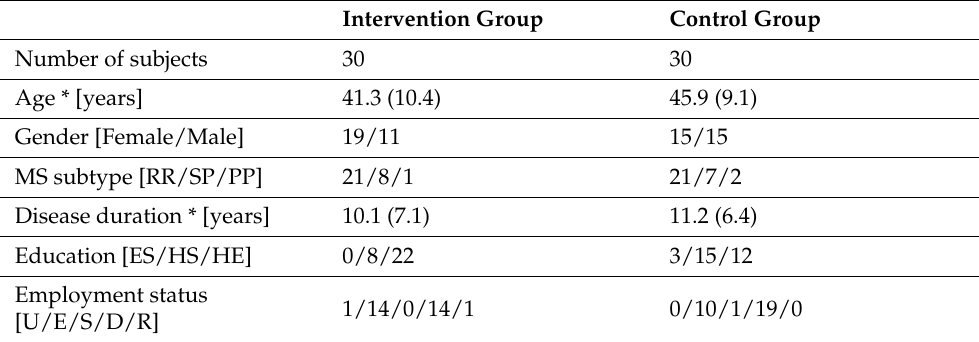
Table 1. Baseline demographic of the study